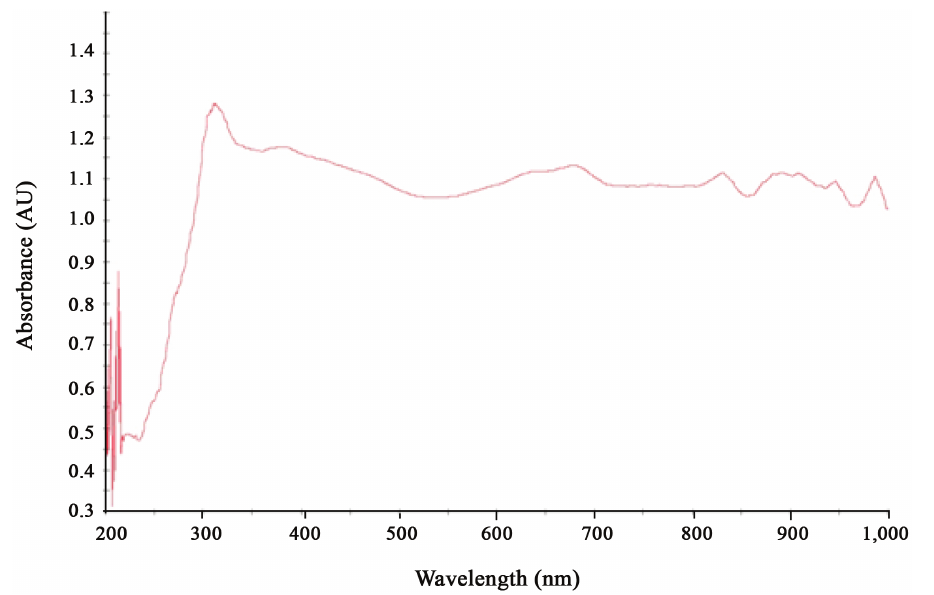
Figure 5: DRS of NiCr 2 O 4 nanoparticles. O nanoparticles 2 4